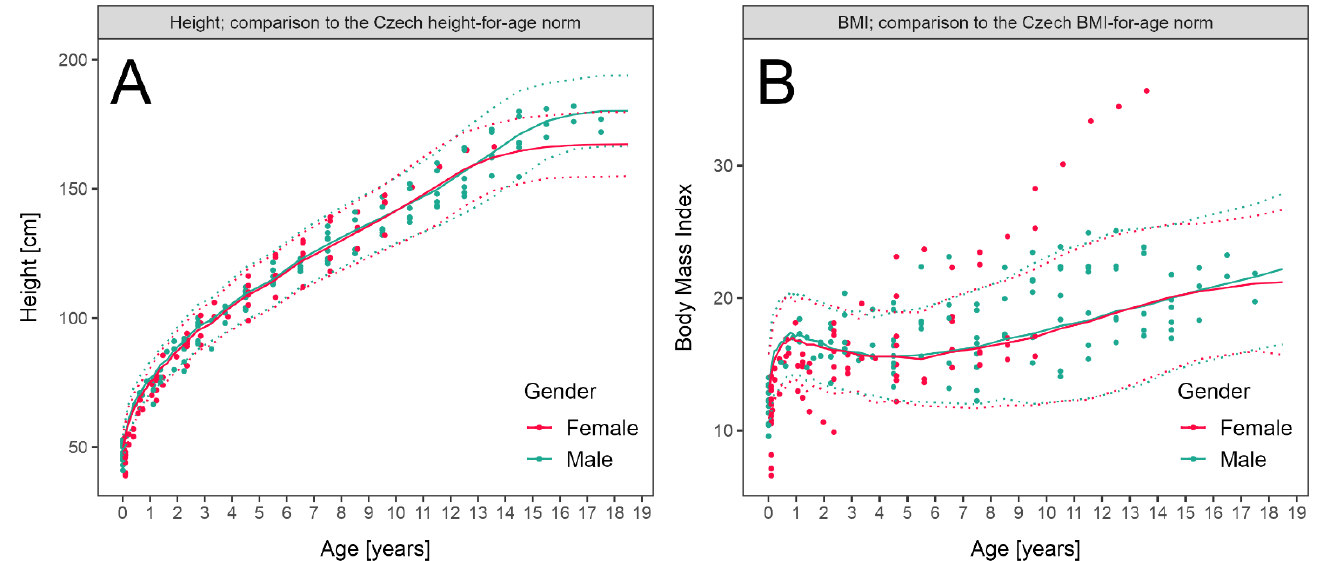
Figure 2. Anthropometric parameters in patients with LCHADD/MTPD: ( A ) Height of patients diagnosed before ENBS (data available in 10 patients, 111 measurements, median 11 measurements per patient) and by ENBS ( n = 16, 95 measure- ments, median 6.5 measurements per patient) during follow-up compared to reference range. ( B ) Body Mass Index of patients diagnosed before ENBS ( n = 12, 111 measurements, median 11 measurements per patient) and by ENBS ( n = 16, 95 measurements, median 6.5 measurements per patient) during follow-up. Patient data are shown as individual points, median and 2–98th centile of sex-adjusted reference ranges for the Czech population are shown as solid and dotted lines, respectively.